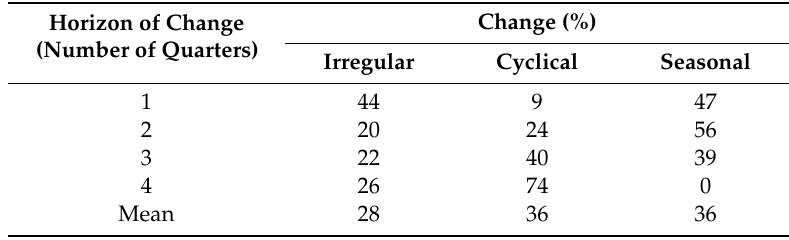
Table 5. Shares of irregular, cyclical and seasonal fluctuations in overall variability of timber supply in Poland in